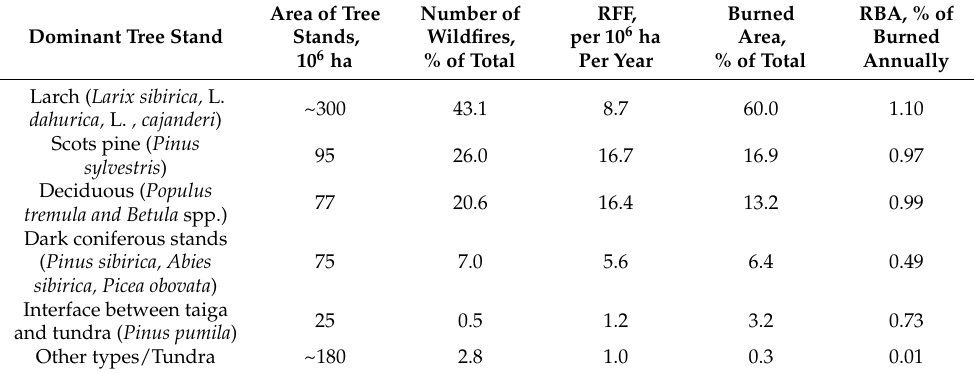
Table 2. The percentage of total (forest and tundra) fire occurrences and burned area and the relative burned area (RBA, %) and the relative frequency of fires (RFF, events per 10 6 ha of forest) by vegetation cover types. Data averaged for